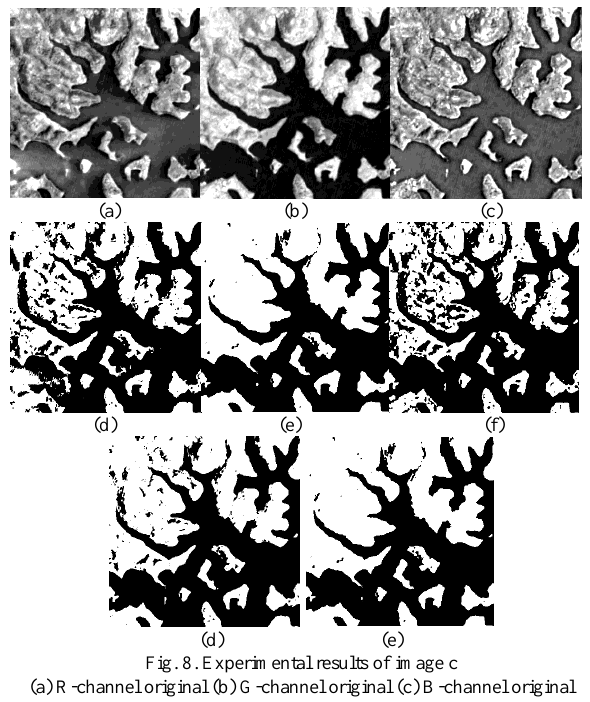
Fig. 8. Experimental results of image